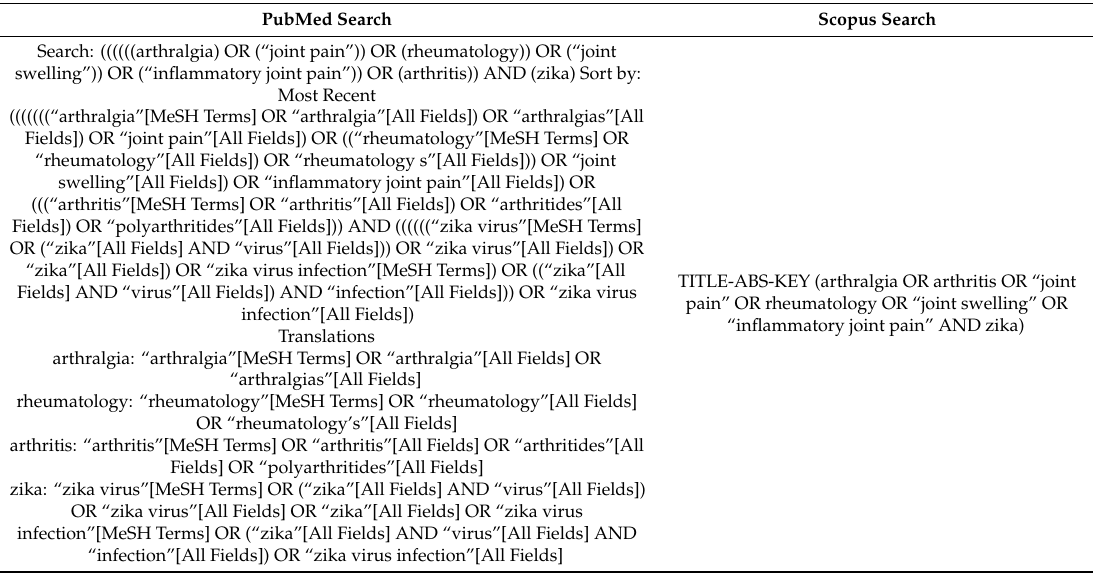
Table 2. Systematic review search